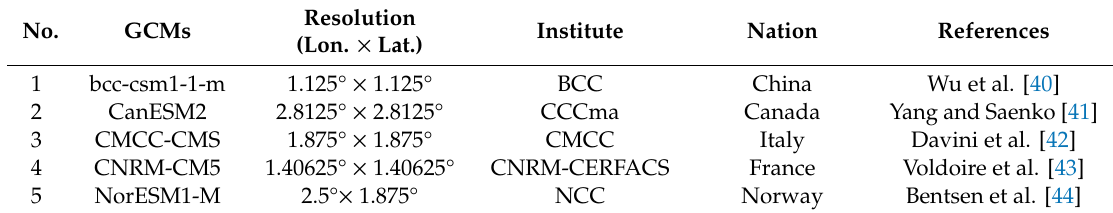
Table 1. List of the five selected global climate models (GCMs) used in this